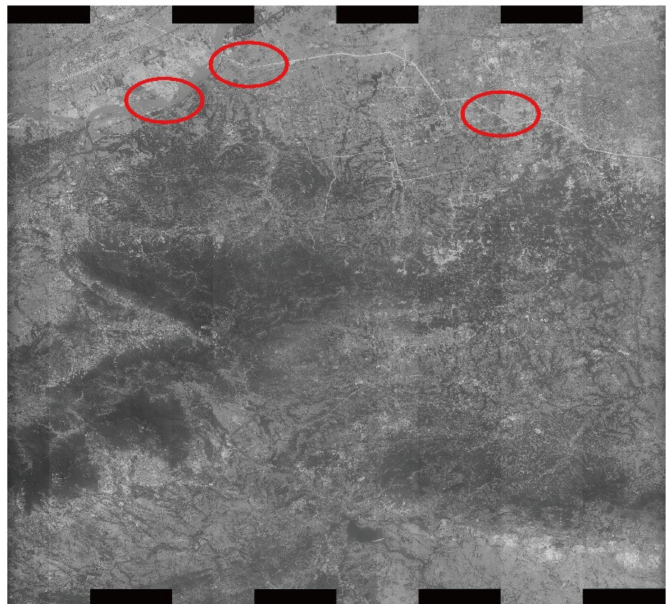
Figure 14. Mosaic Image for TH-1 HR Camera.